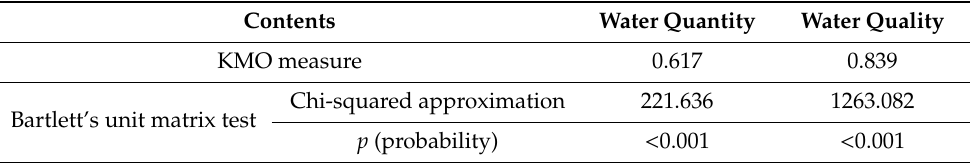
Table 10. The results of Kaiser–Meyer–Olkin’s (KMO) values and Bartlett’s test by water quantity and water quality.